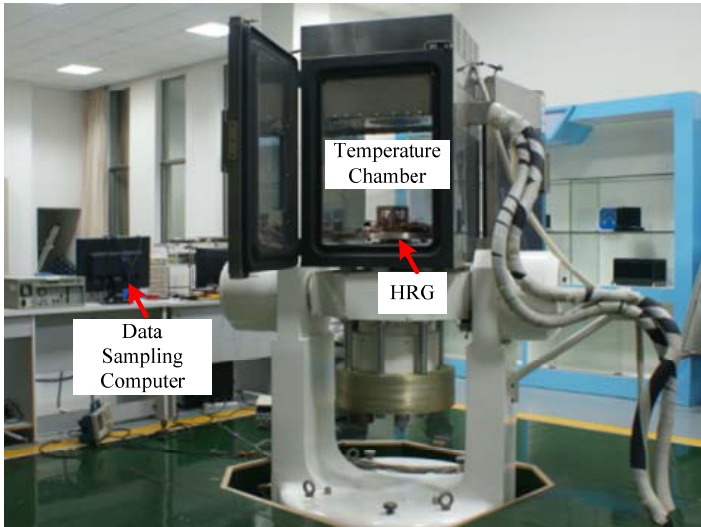
Figure 2. The temperature experiments carried out by a controlled temperature